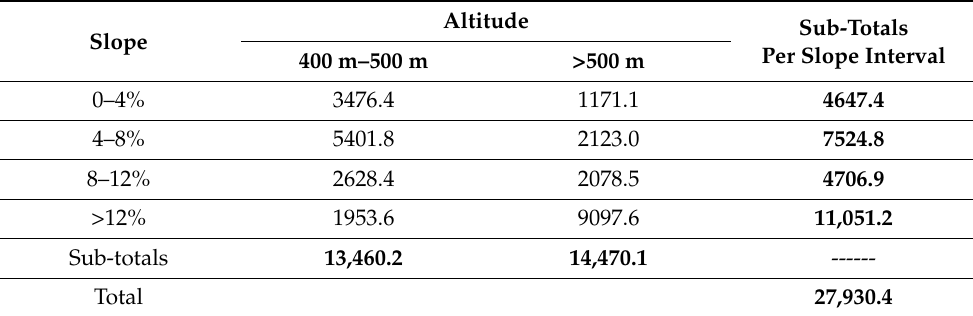
Table 2. Available areas (ha) by two altitude classes and four slope intervals.